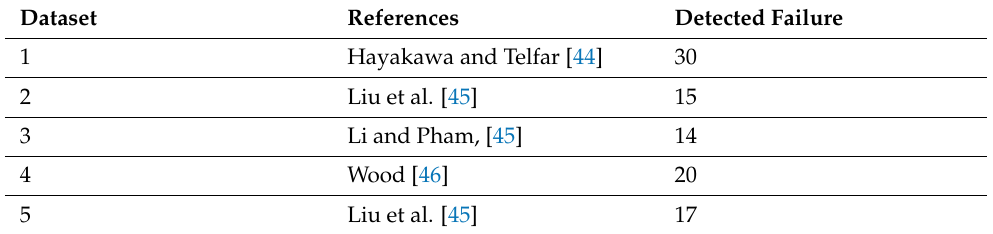
Table 1. References for the datasets.